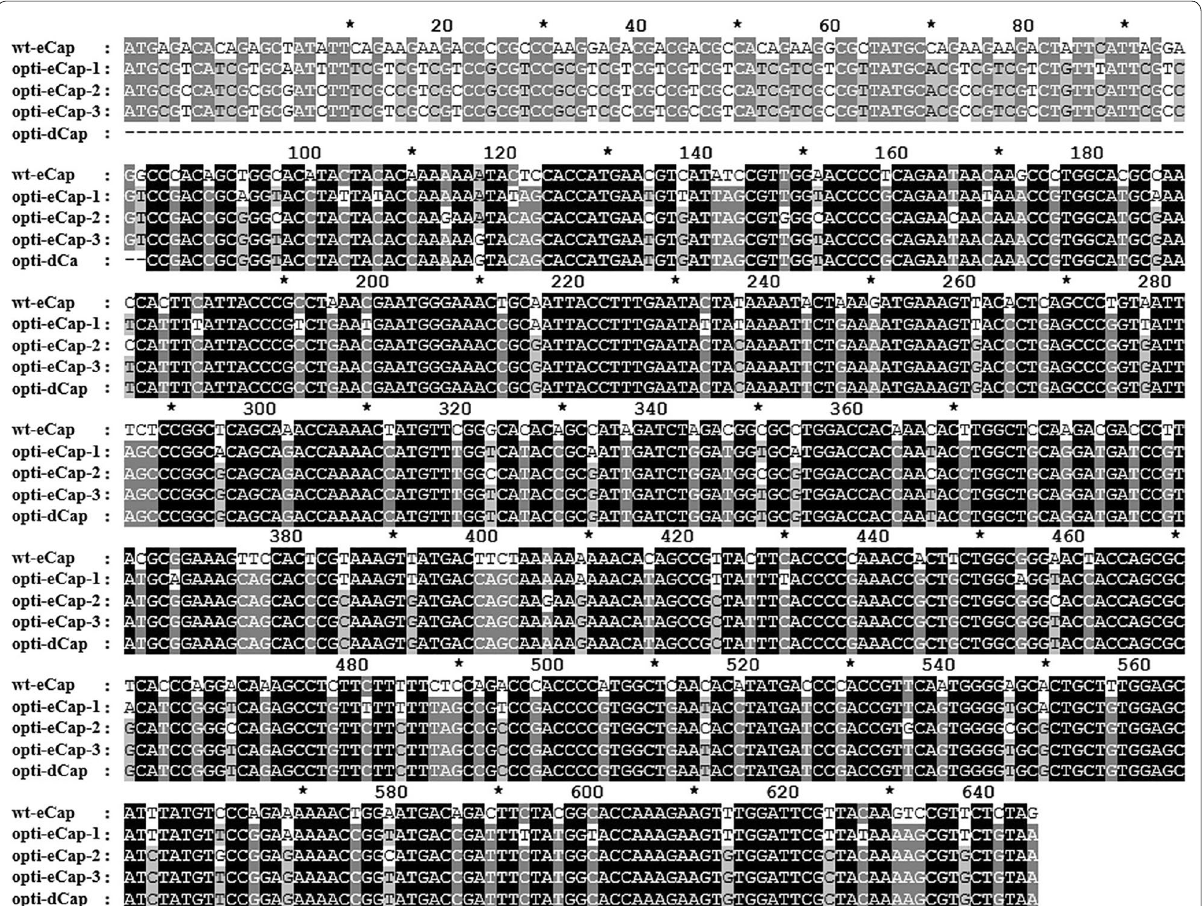
Fig. 1 Nucleotide sequence alignment between the wild‑type and optimized Cap genes. Full‑length Cap of PCV3 (645 bp) was optimized for E. coli codon